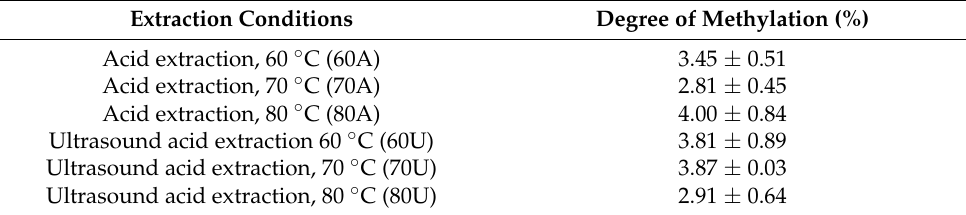
Table 3. The degree of esterification of kaffir lime pectins determined by the titration method.